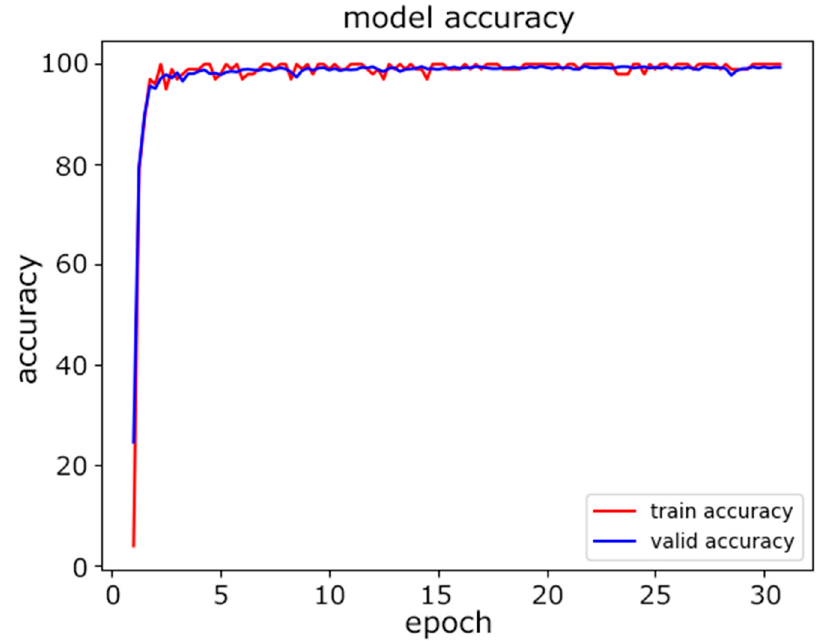
Figure 7. CNN model accuracy.